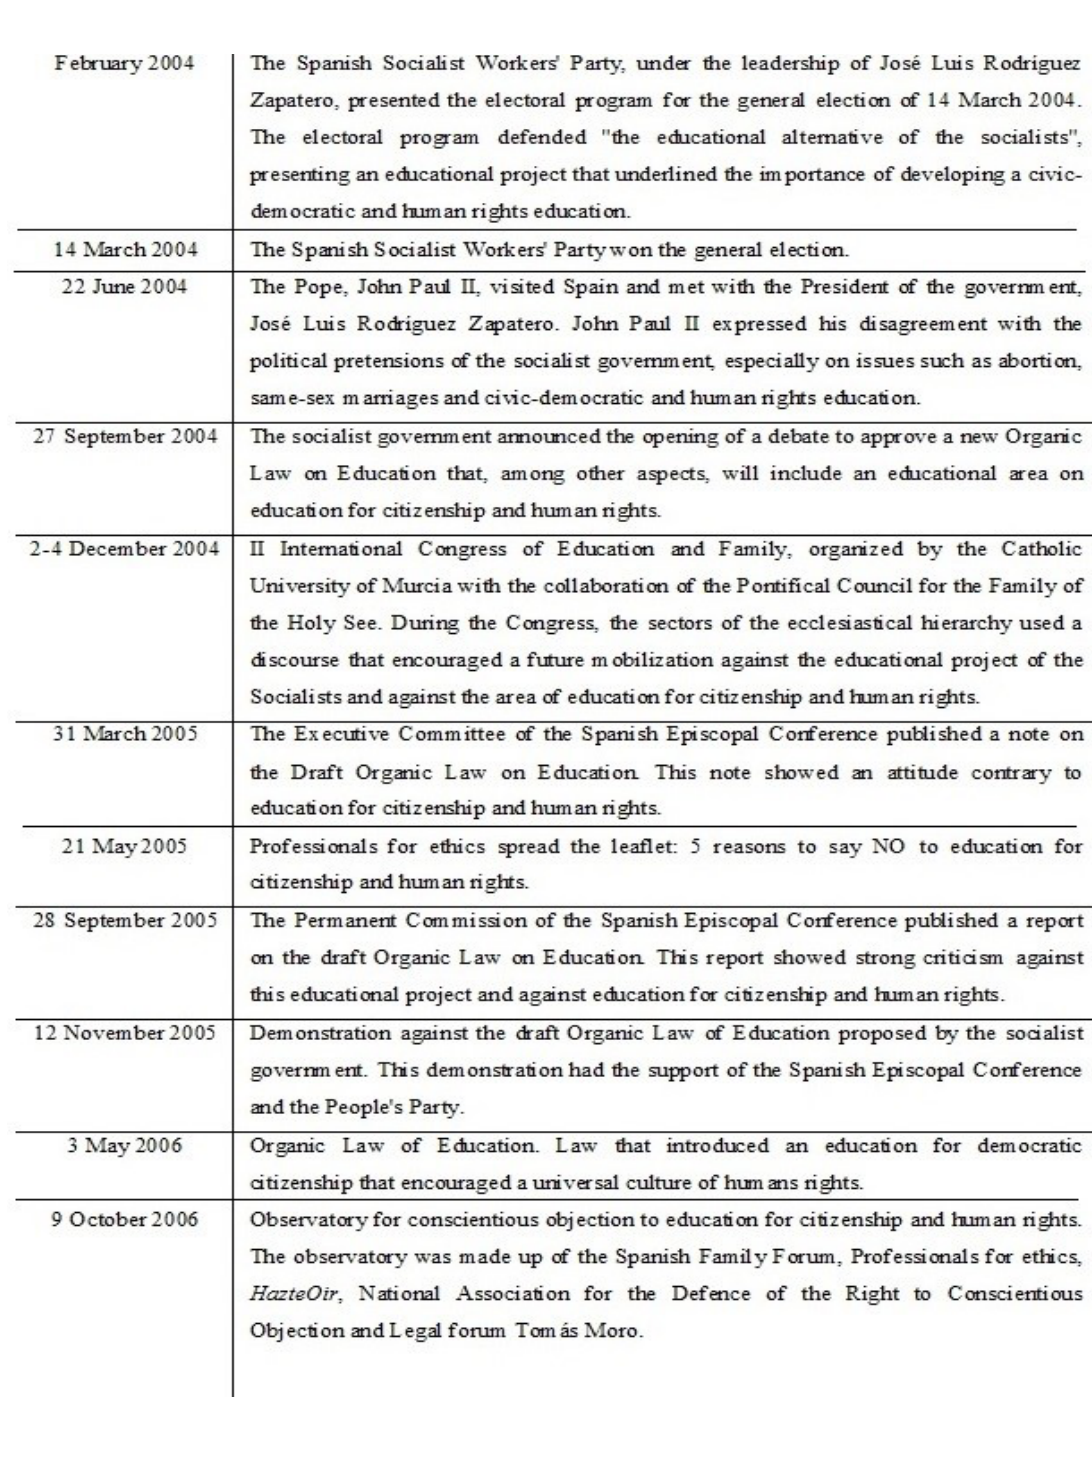
Figure 1. Mobilization against education for citizenship and human rights in Spain. Some of the most important